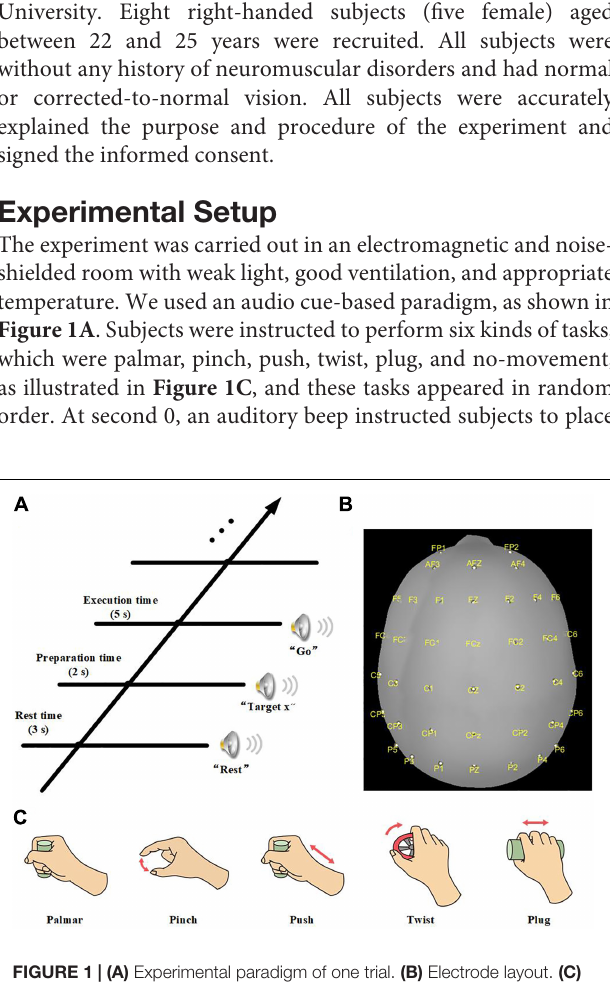
FIGURE 1 | (A) Experimental paradigm of one trial. (B) Electrode layout. (C) Five daily used natural reach-and-grasp